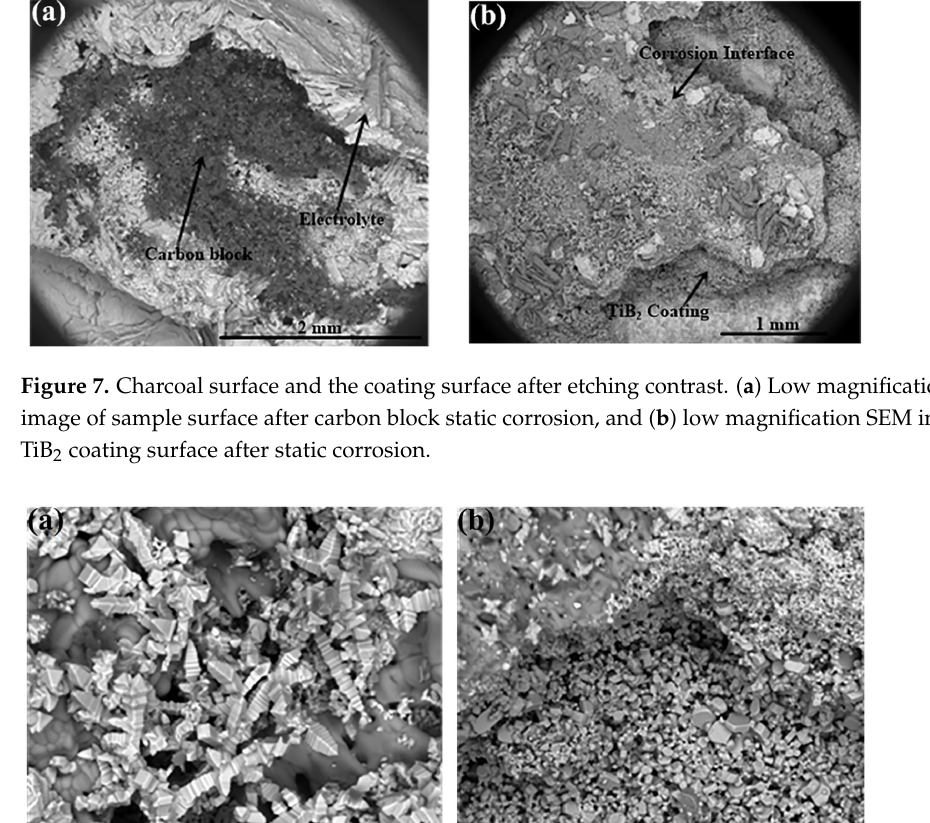
Figure 7. Charcoal surface and the coating surface after etching contrast. ( a ) Low magnification SEM image of sample surface after carbon block static corrosion, and ( b ) low magnification SEM image of TiB 2 coating surface after static corrosion. Figure 8. ( a ) Surface and ( b ) cross section after TiB 2 coating corrosion. Figure 8. ( a ) Surface and ( b ) cross section after TiB 2 coating